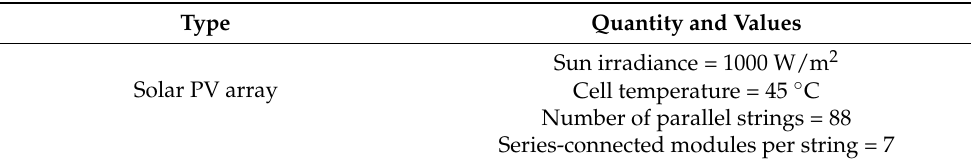
Table 3. Technical specifications of PV system.